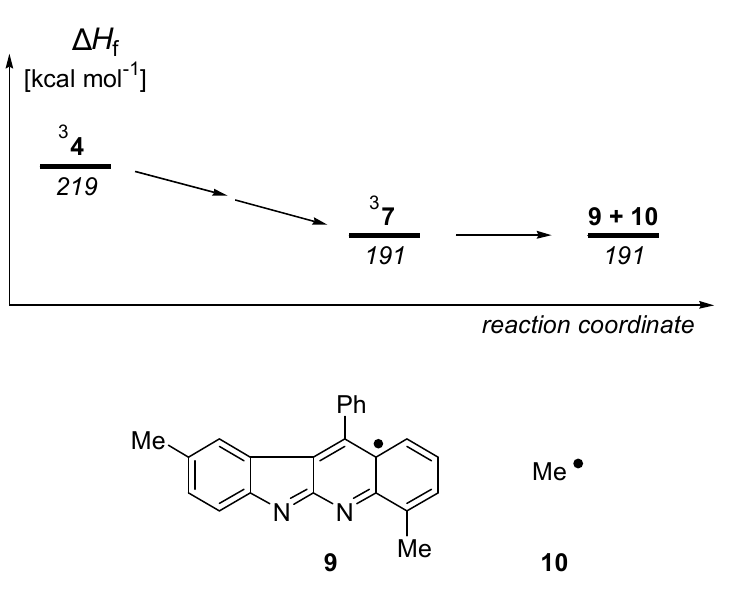
Figure 1 . Heat of formation ∆ H (see italic numbers, calculated by AM1 without C.I. ) of f the triplet excited key intermediates in the photochemical transformation 4 → 9 + 10